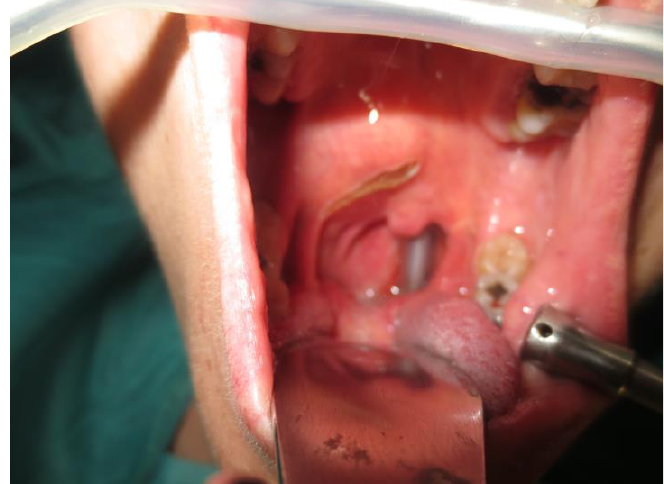
Figure 1. Incision. Figure 1. Incision.